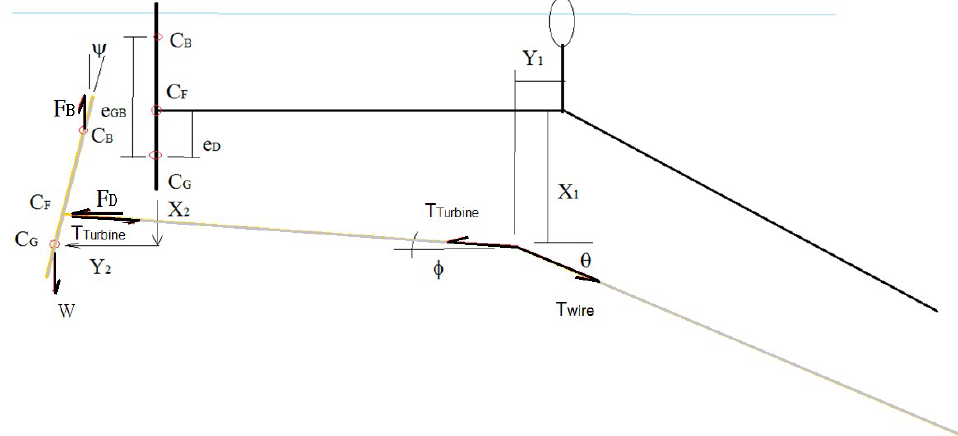
Figure 3. Coordinate and force distribution of the system.